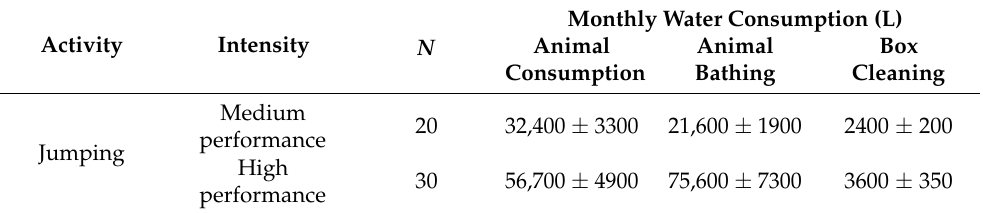
Table 1. Monthly water consumption (L) by animals drinking, water for animal bathing, and water for box cleaning. N : samples